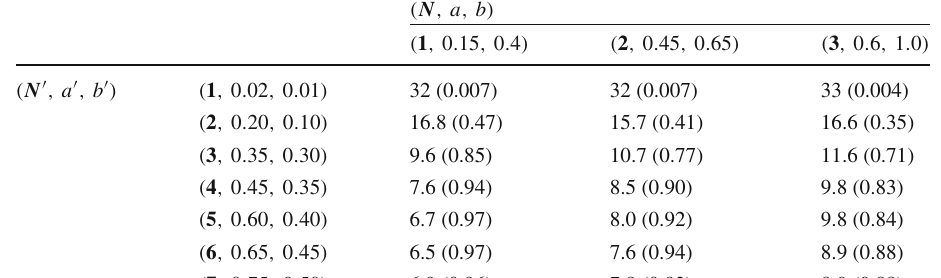
Table 6 Simulation for the SU ( 5 ) model for the scenario with tan β = 10. We display the χ 2 of the physical couplings, corresponding to 15 degrees of freedom. The parentheses give the p value, the proportion of models with lower probability density (larger χ 2 ) than the SM